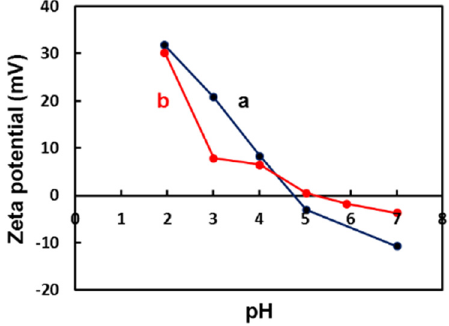
Figure 4: Zeta potentials of pollen ( a ) and pollen@FePO 4 ( b ) .